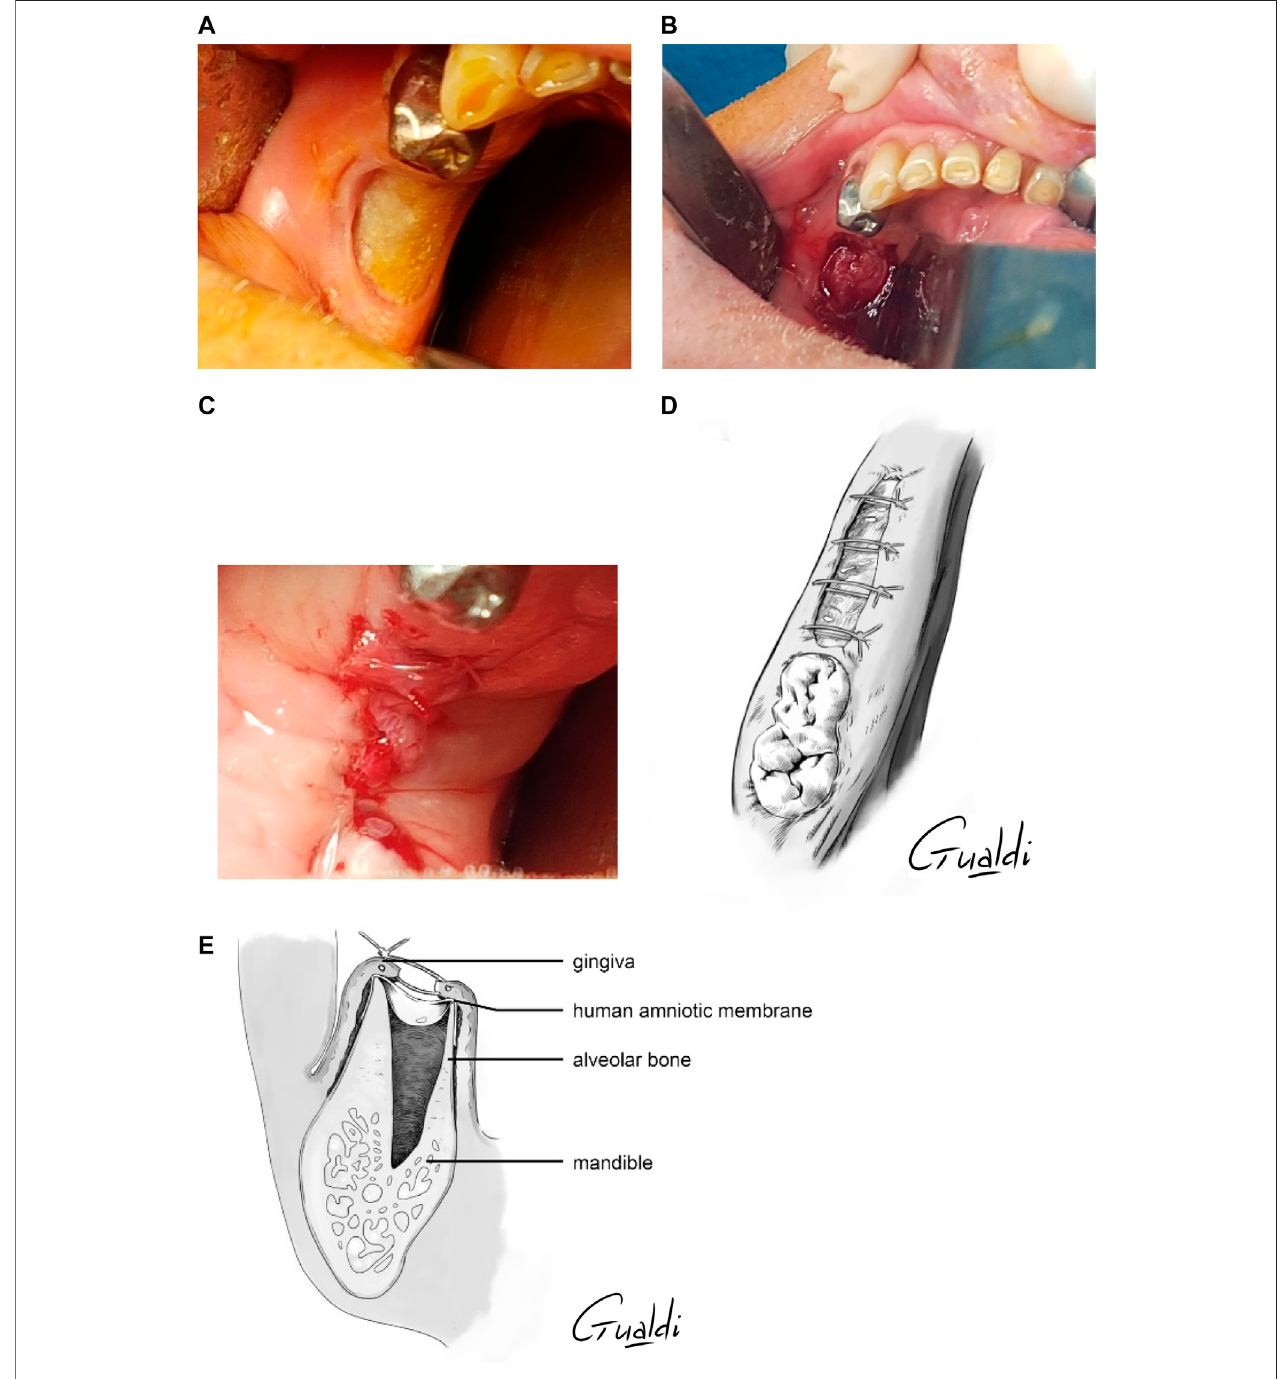
FIGURE 5 | Patient 3 (A) Sector 3 posterior stage 2 MRONJ. (B) hAM application. (C) Non-hermetic sutures from “ hAM implantation with partial coverage ” nomenclature (Odet et al., 2021). Here the gingiva was sutured above the hAM, but leaving the hAM exposed in the oral cavity. (D) Upper view and (E) Sagittal section illustrations of “ hAM implantation with partial coverage ”